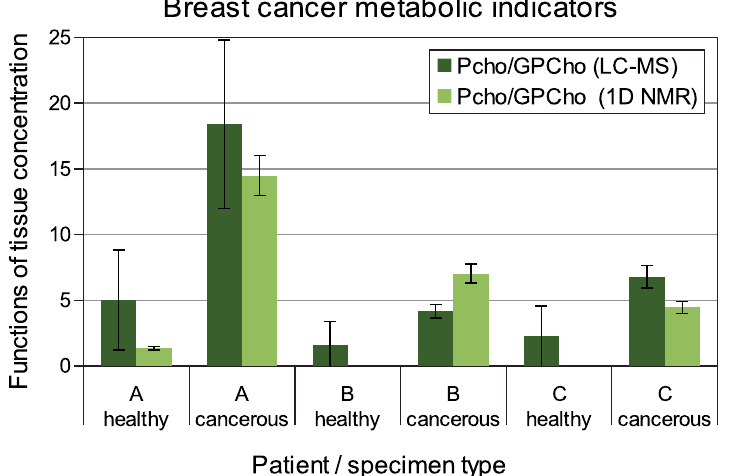
Fig. 8. Bar chart representation of the ratio of PCho and GPCho tissue concentrations in bioptic aqueous extracts. Both LC-MS and NMR results are shown, where